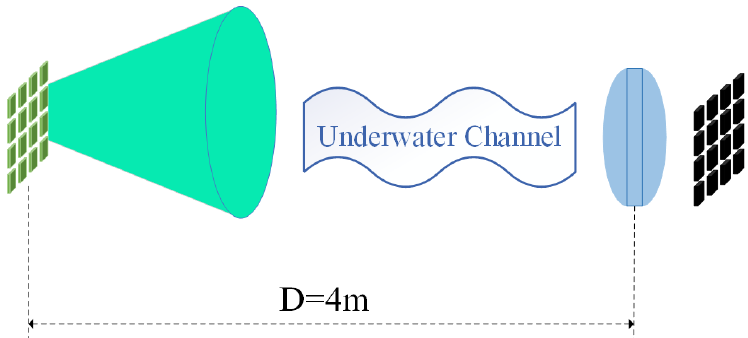
Figure 1. Model of underwater imaging optical communication